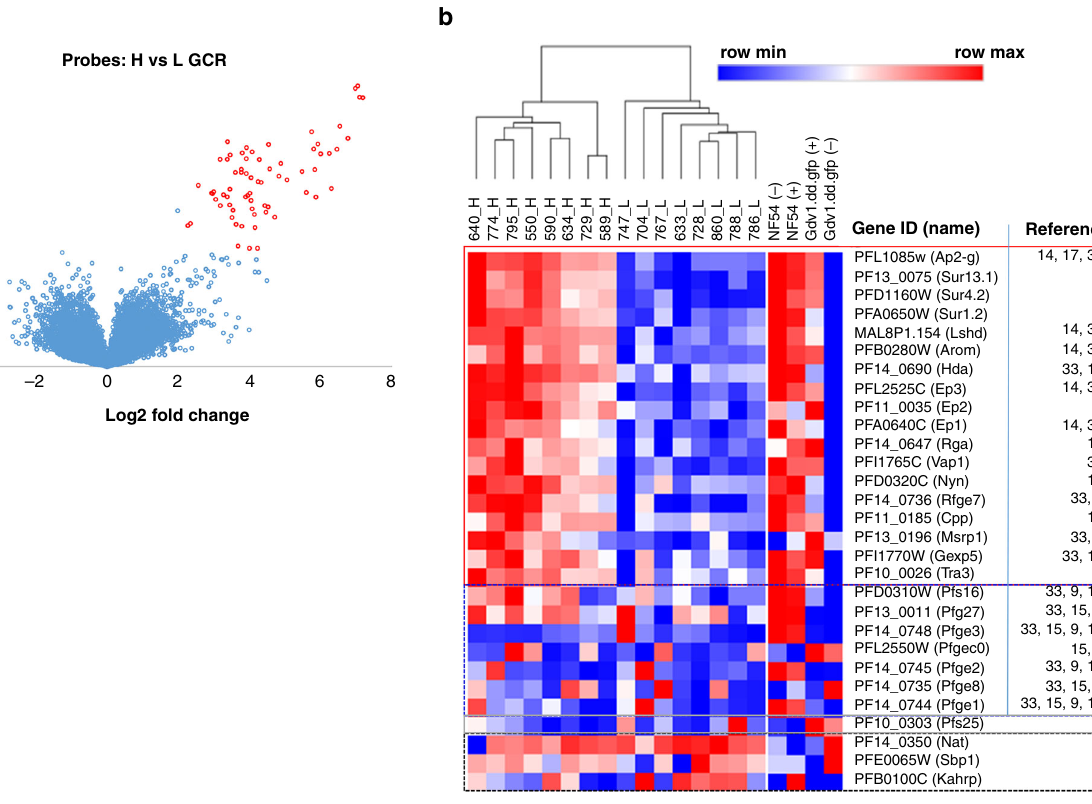
Fig. 1 Transcriptome pro fi ling of P. falciparum in vivo gametocyte-committed rings. a Volcano plot of the microarray signal difference between RNA from the high (H)- ( n = 8) and low (L)- ( n = 8) gametocyte-conversion rate (GCR) cohort D0 blood samples and the corresponding P value from a two-sided t test ( y axis). Probes with > 2.0-fold differences ( x axis) and a false discovery rate (FDR) ≤ 0.16 to control for multiple comparisons are shown in red. b Cluster analysis and heatmap of the relative expression of the indicated genes in both in vivo samples [H-GCR (sample#_H) and L-GCR (sample#_L) samples], and in vitro samples (gametocyte-producing lines, NF54 − / + Shield 1 (Shld1) ( − , + ) and Pfgdv1.gfp.dd + Shld1( + ), and gametocyte-de fi cient line Pfgdv1.gfp.dd - Shld1 (-)). The relative expression of each gene is indicated by a color gradient from highest (dark red) to lowest (dark blue). The red box includes the 18 genes signi fi cantly upregulated in the H-GCR samples, the blue and gray boxes are previously reported early and late gametocyte-speci fi c genes, respectively, and the black box contains ring-stage-speci fi c genes. Reference to prior gene expression studies is indicated at the right 9,10,13 – 15,17,33 . Source data are provided as a Source Data fi